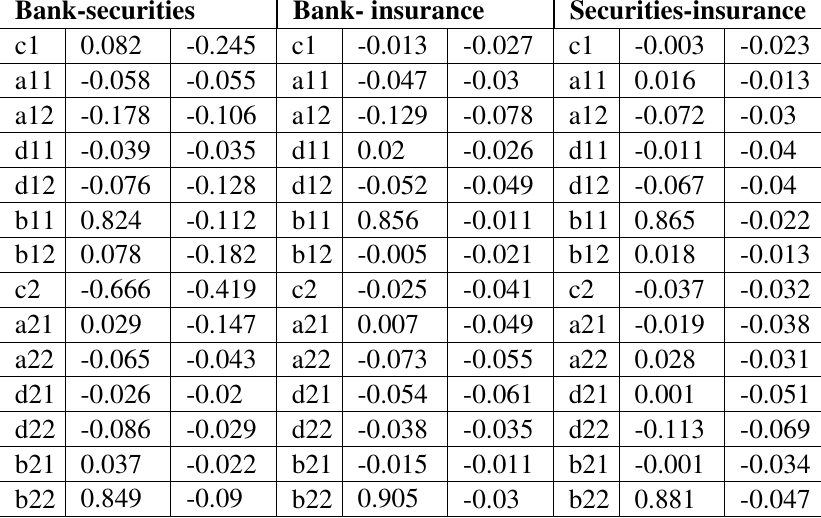
Table 3 Estimated results of the asymmetric MVMQ-CAViaR